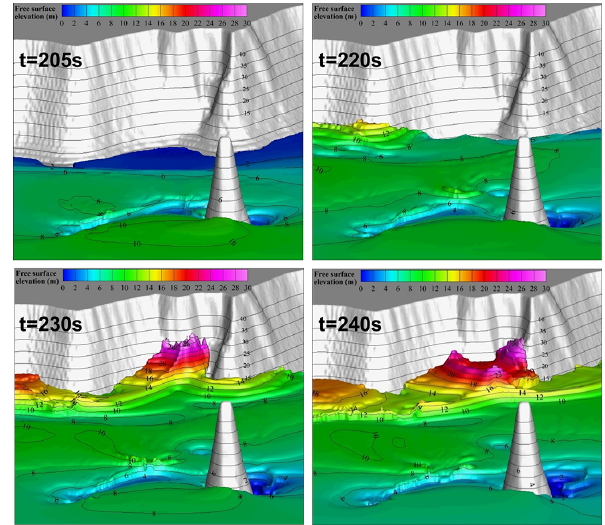
Figure 8. The snapshots of time-varying sea surface elevation dis- tribution computed with two